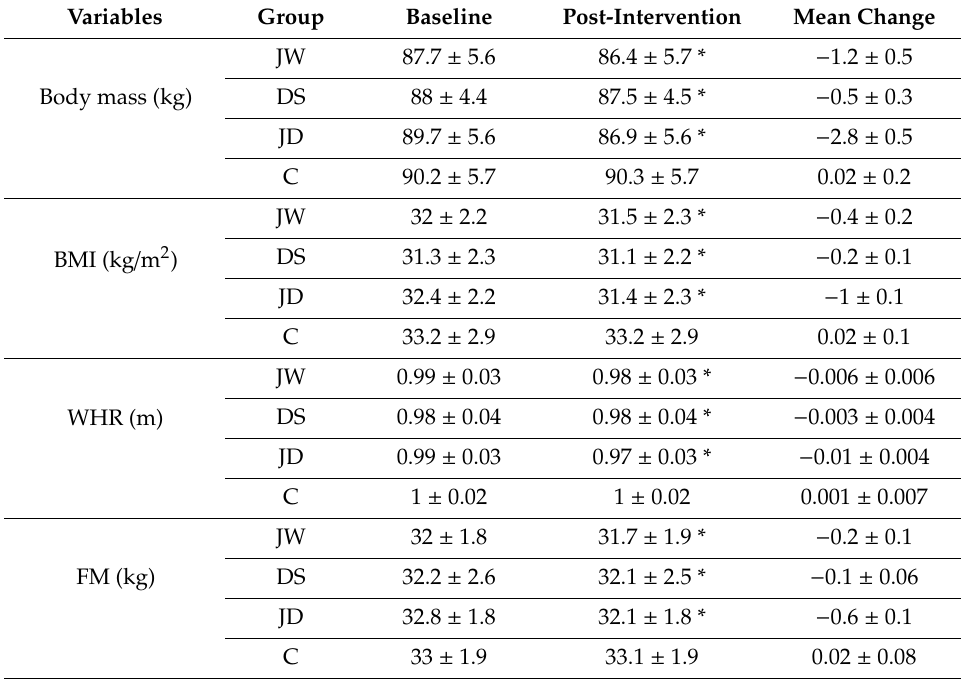
Table 4. Physiological characteristics of participants. Data are mean ±